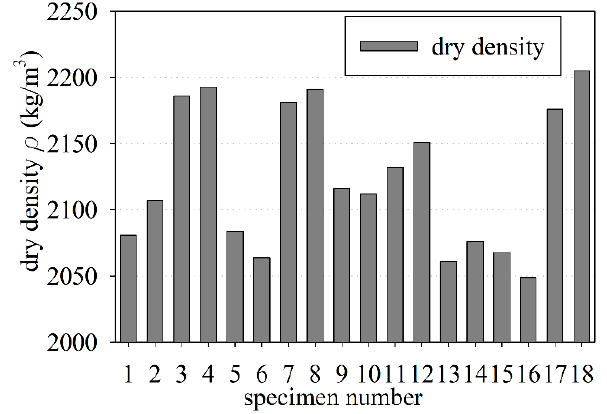
Figure 4. Measurement of the old concrete dry density.